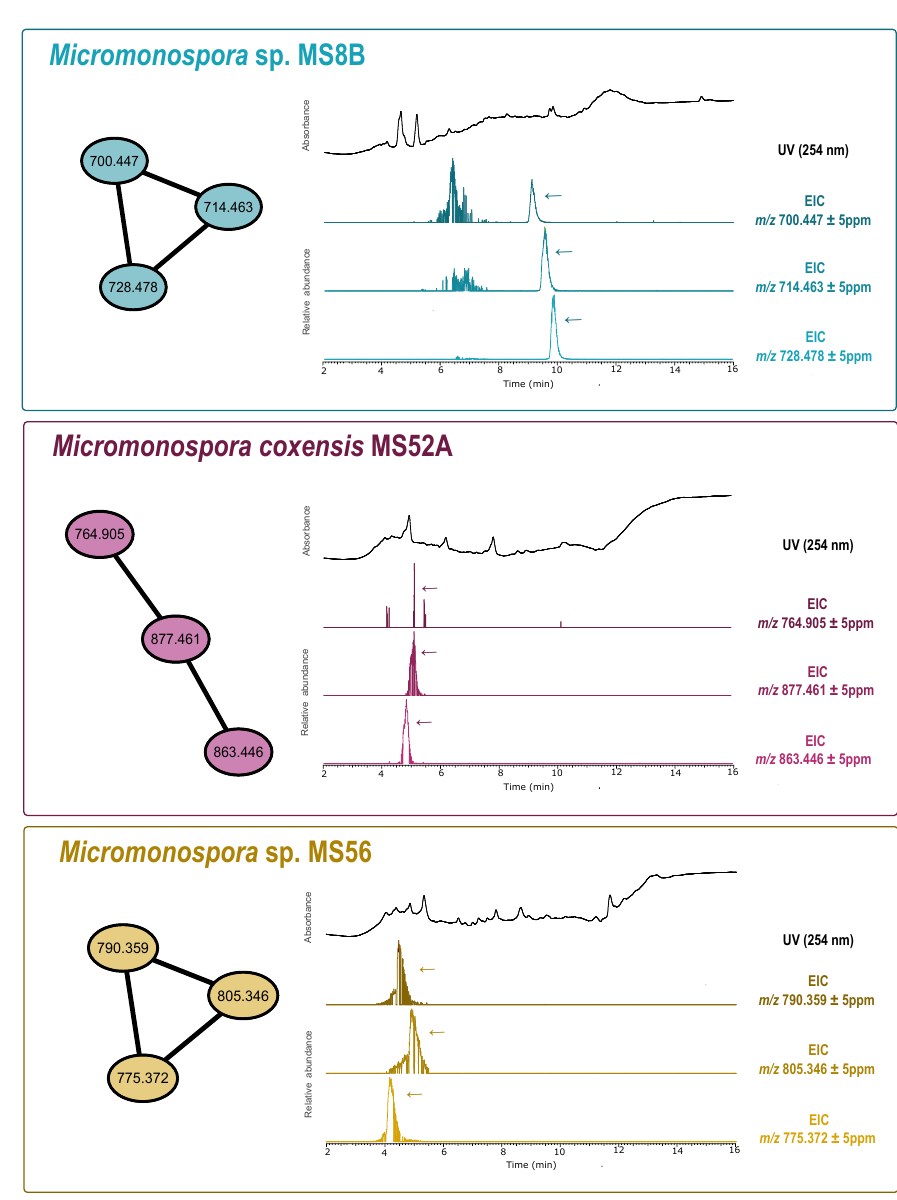
Figure 4. Analysis of the GNPS-generated molecular network LC-HRESI MS / MS of Actinobacteria crude extracts that showed bioactivity. The extracts obtained from one Micromonospora coxensis (MS52A) and two Micromonospora sp. (MS8B and MS56) exhibited exclusive clusters for each strain (represented by connected ellipses and marked with the corresponding m / z value for the parental ion) that did not match any entries in the databases used for dereplication. For each cluster we show the respective UV chromatogram and extracted ion chromatograms (EICs). Arrows depict peaks corresponding to the highlighted GNPS